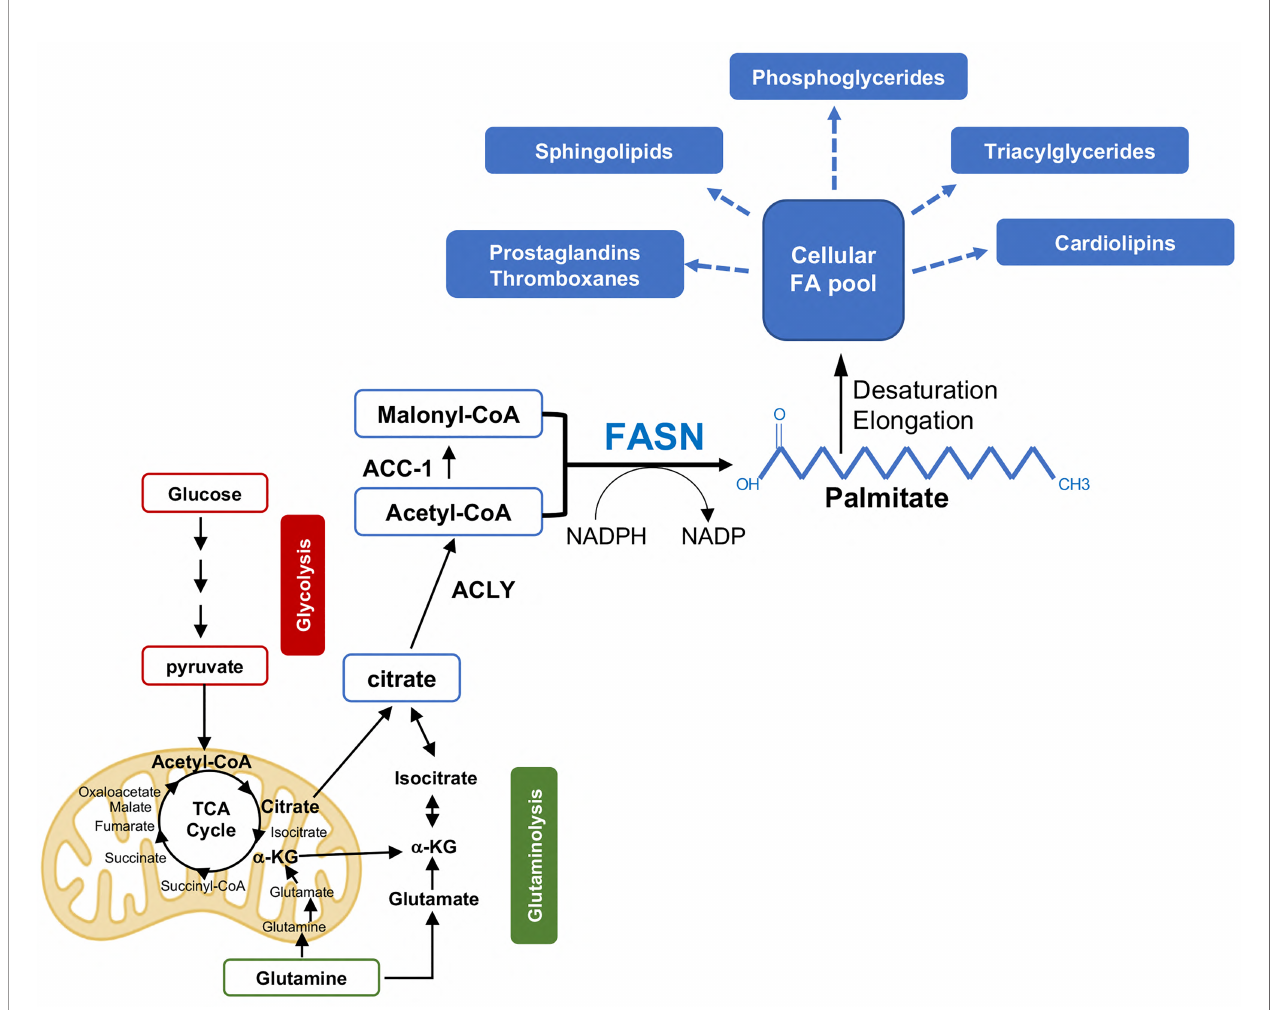
FIGURE 1 | De novo FA synthesis in PCa progression. Acetyl-CoA derived from glucose and glutamine metabolism is exported to the cytosol in the form of citrate and reconverted to acetyl-CoA by the enzyme ATP citrate lyase (ACLY). Acetyl-CoA is then converted to Malonyl-CoA by the Acetyl coenzyme A carboxylase a (or ACC-1). Fatty acid synthase (FASN) catalyzes the condensation of Acetyl-CoA and Malonyl-CoA (in the presence of the reducing equivalent icotinamide adenine dinucleotide phosphate (NADPH)) to generate the 16-carbon FA palmitate, a saturated FA that undergoes further modi fi cations (i.e., elongation/desaturation) to form more complex lipids. The latter serve as energy source, building blocks, and in fl ammatory/immune modulators to sustain PCa progression and CR. a KG, alpha-ketoglutarate; NADPH, Nicotinamide adenine dinucleotide